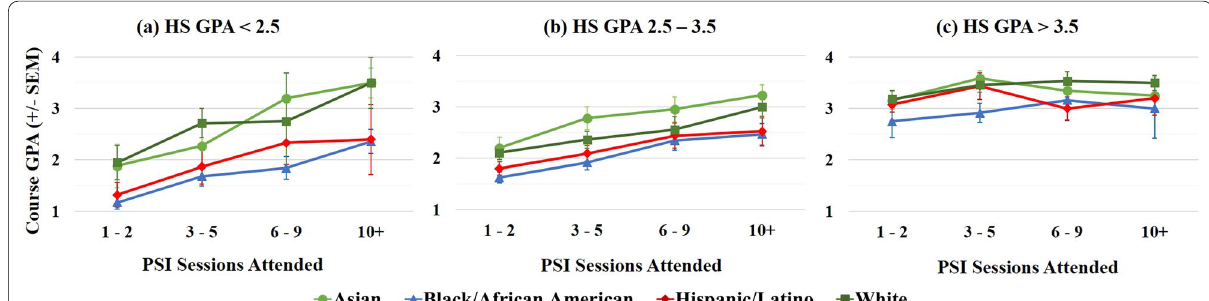
Fig. 6 Comparison of the effects of PSI participation on final course GPA for students identifying with the four racial/ethnics group investigated here, separated by incoming HS GPA: a < 2.5 ( n